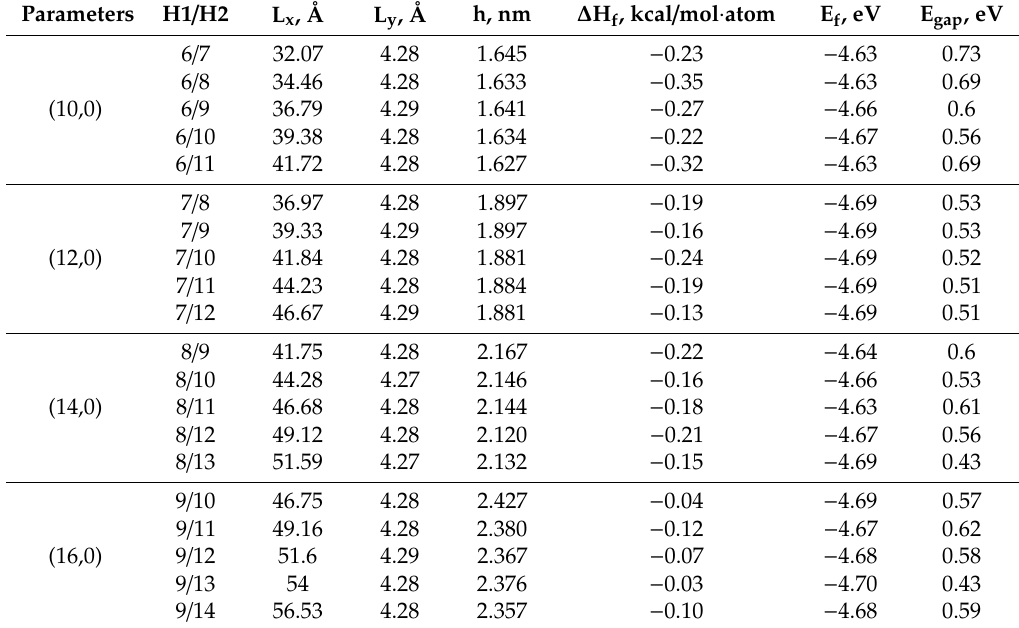
Table 1. Geometric and energy characteristics of supercells of graphene / SWCNT composite films. Parameters H1 /